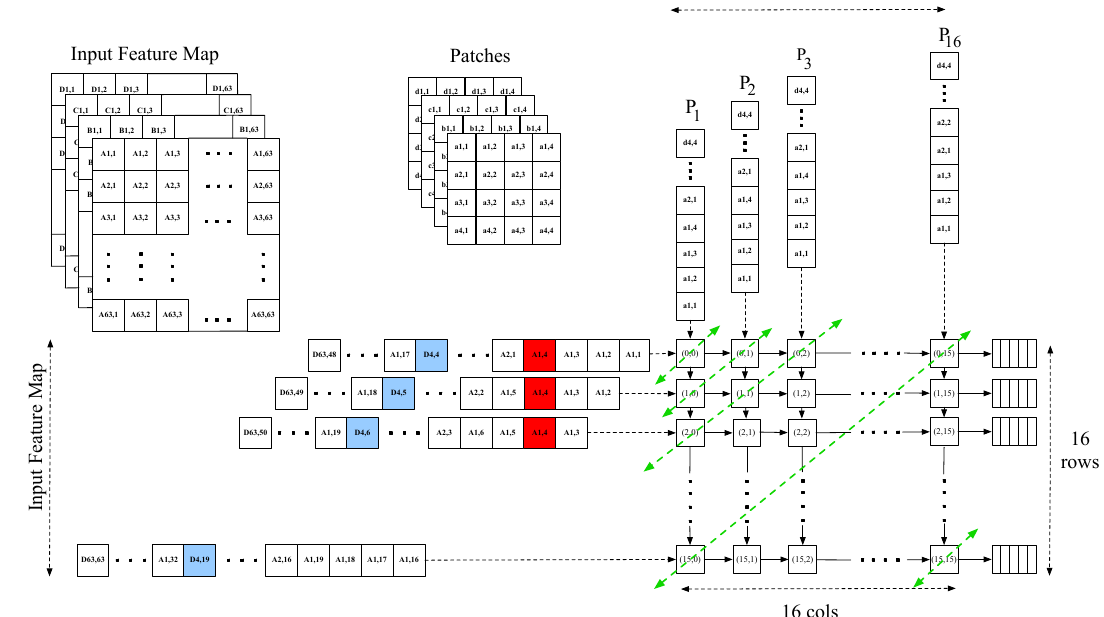
Figure 4. The SAFA dataflow diagram. We mainly use the OS dataflow for SAFA. The green dashed line indicates the calculation sequence of each PE in SAFA. The same red color values A 1,4 represent the data reused in our dataflow. In contrast, the blue values donate the last pixels of the C1 input required to calculate an output